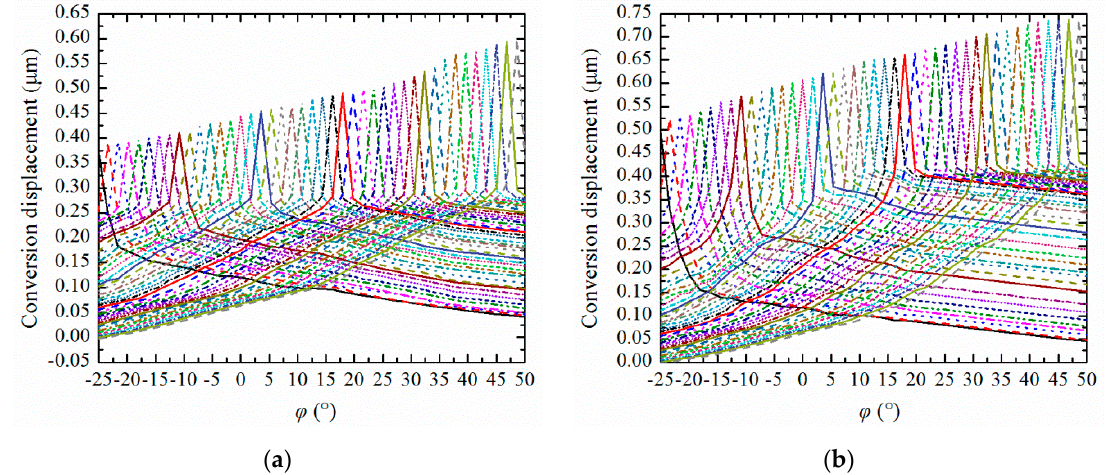
Figure 7. ( a ) The conversion displacement of the conventional flexible wheel; ( b ) the conversion displacement of the disposable flexible wheel.